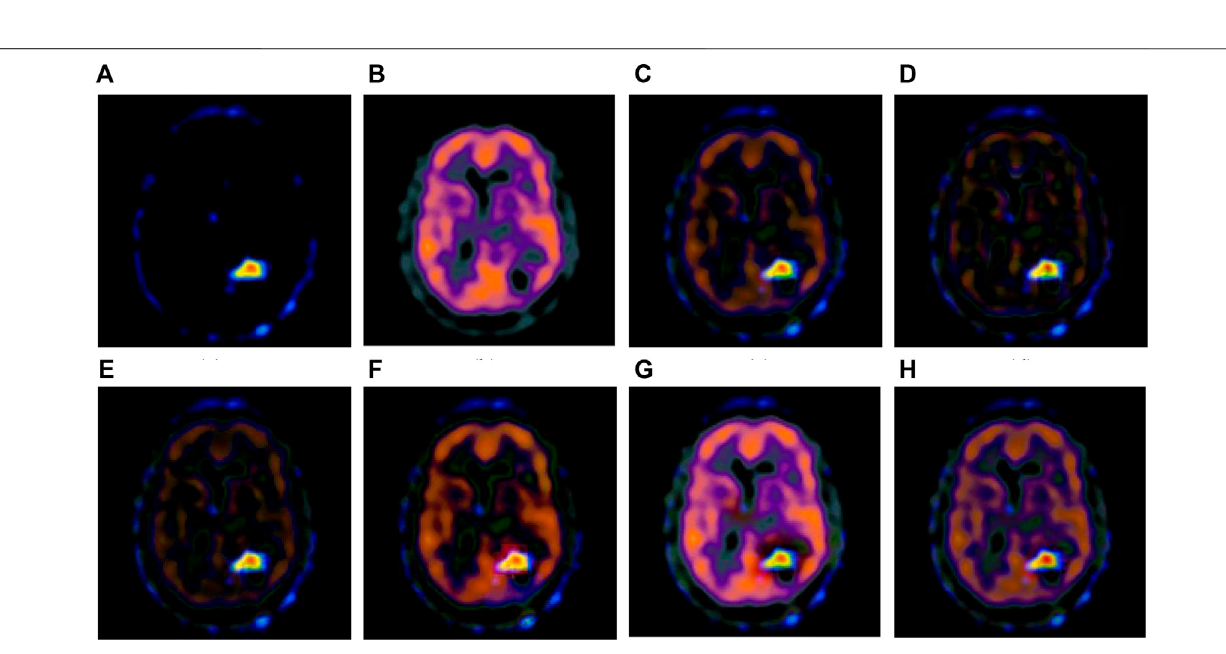
Frontiers in Genetics |